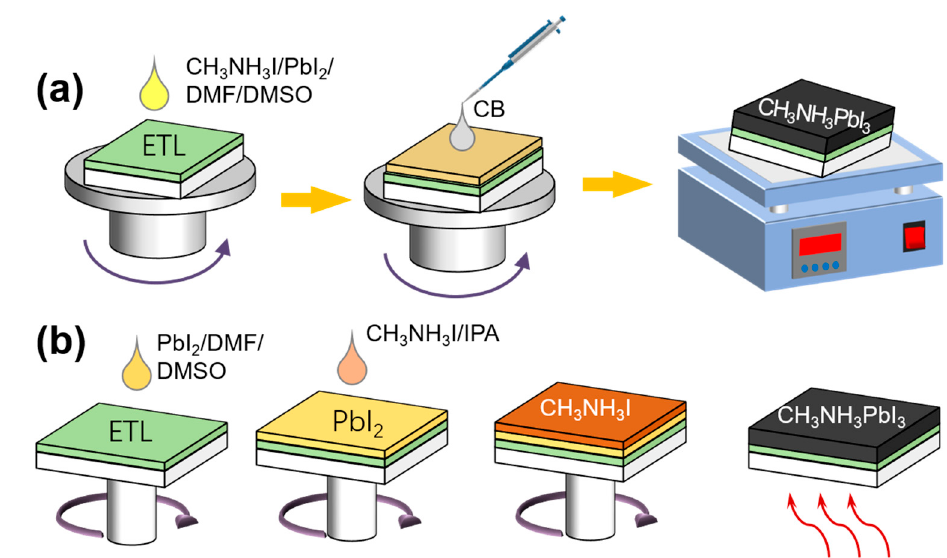
Figure 2. ( a ) One- and ( b ) two-step